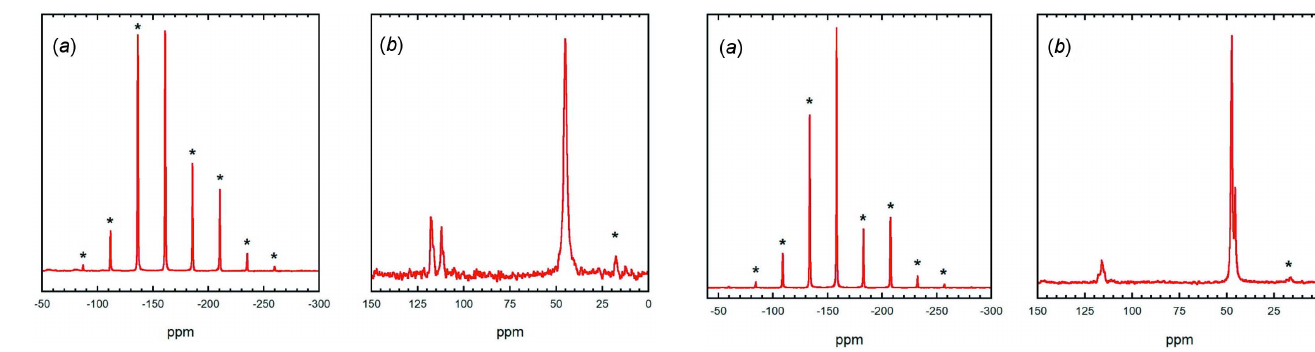
Figure 6 ( a ) 31 P MAS NMR spectrum for 1 obtained using a spinning speed of 5 kHz. The sideband pattern is corresponds to a chemical shift anisotropy (csa) with isotropic shift of (cid:4) 161 ppm, d aniso = (cid:4) 67.7 ppm, and h = 0.34; ( b ) 13 C MAS NMR spectrum for 1 obtained using a spinning speed of 12.5 kHz. Note that in both spectra, spinning sidebands are marked with asterisks ( *) .